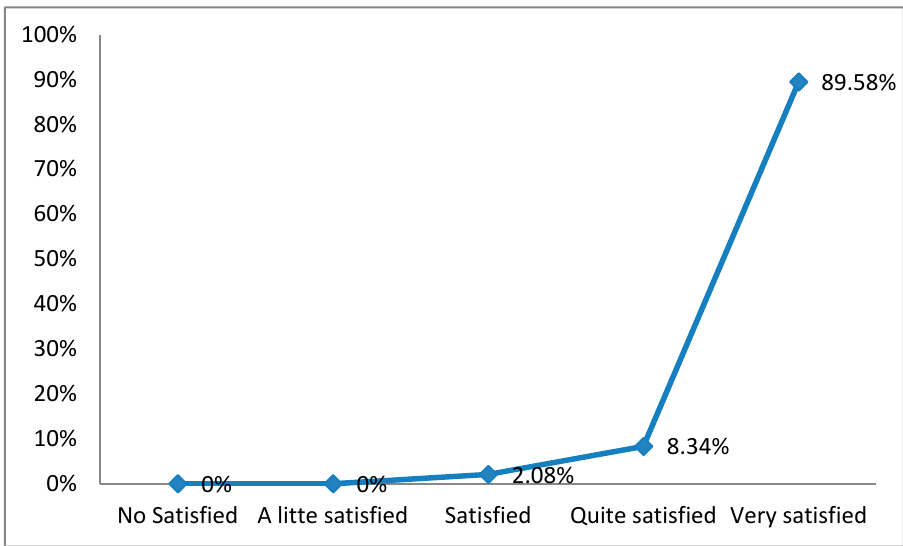
Figure 2. Satisfaction of the participating student in the intervention (teaching round).